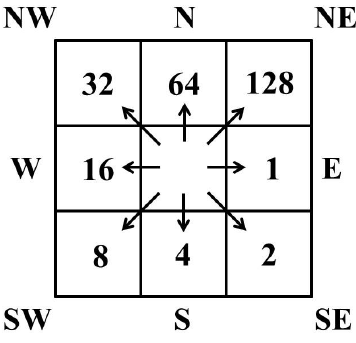
Fig. 6. D8 ESRI direction code